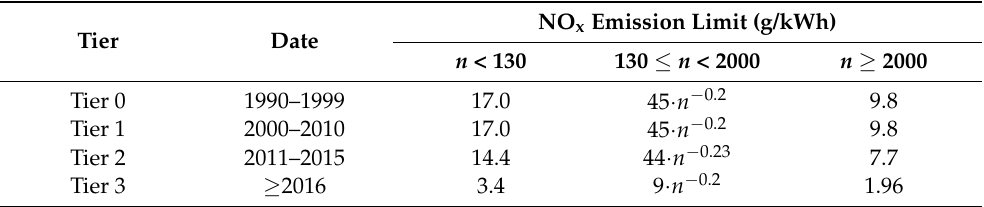
Table A1. Revised Annex VI of MARPOL Convention—NO x emission limit ( n -rated engine speed in rpm).